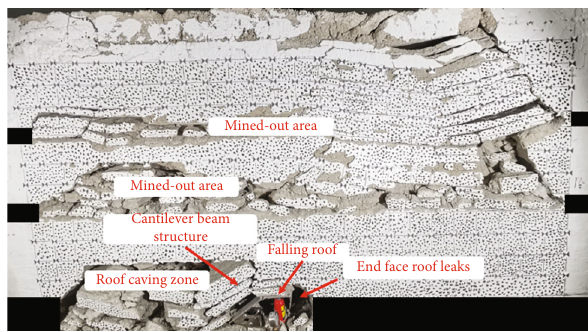
Figure 13: End face roof leak